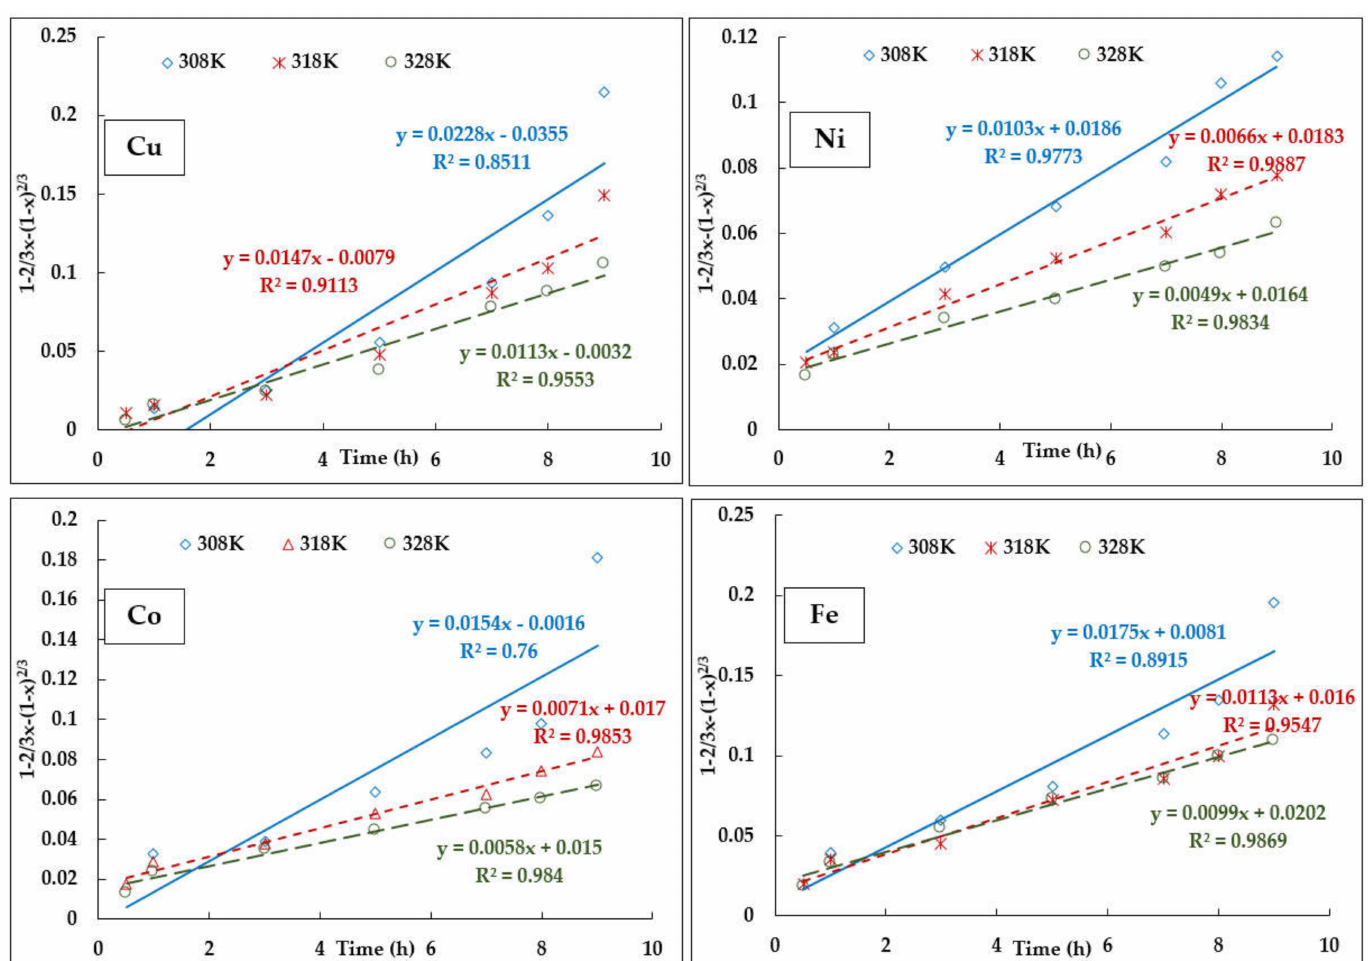
Figure 13. Di ff usion control model for leaching of Cu, Ni, Co, and Fe from converter slag using 2 N citric acid in temperature range (308–328